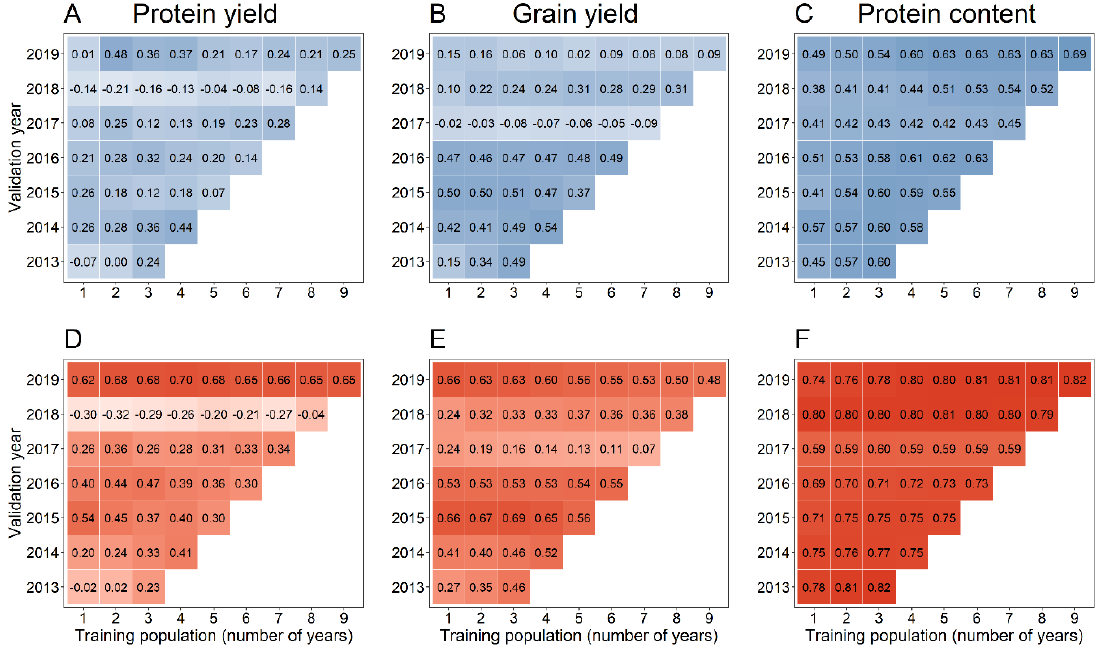
Figure 4. Prediction accuracy for protein yield using pedigree-genomic-based ( A – C ; blue coloured) as well as pedigree-genomic-assisted ( D – F ; red coloured) forward predictions with the latter exploiting pre-existing information from preliminary yield trials. The training population for each prediction model was built by randomly sampling 100 lines from one to nine years preceding the respective validation year. A darker colouring generally indicates a higher prediction accuracy.